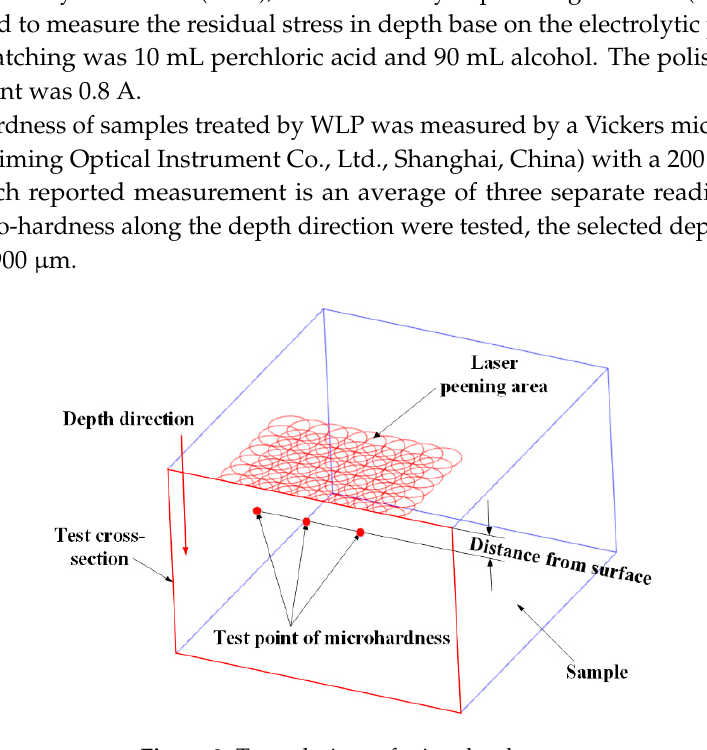
Figure 3. Test solutions of micro ‐ hardness.